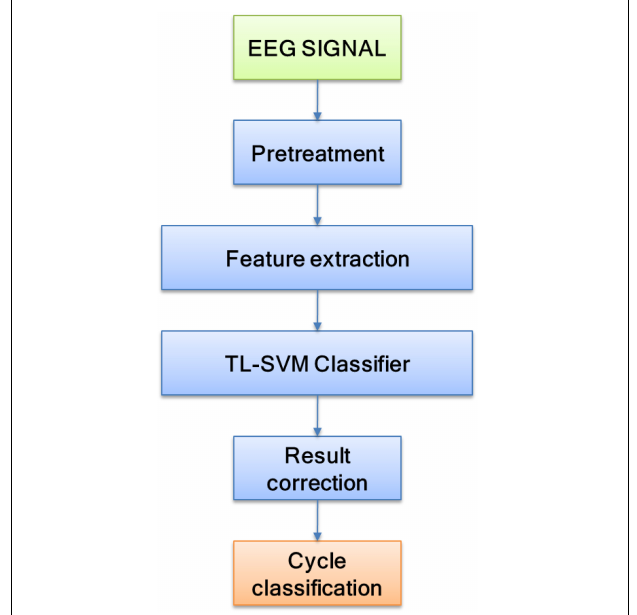
FIGURE 2 | Flowchart of the sleep staging method.